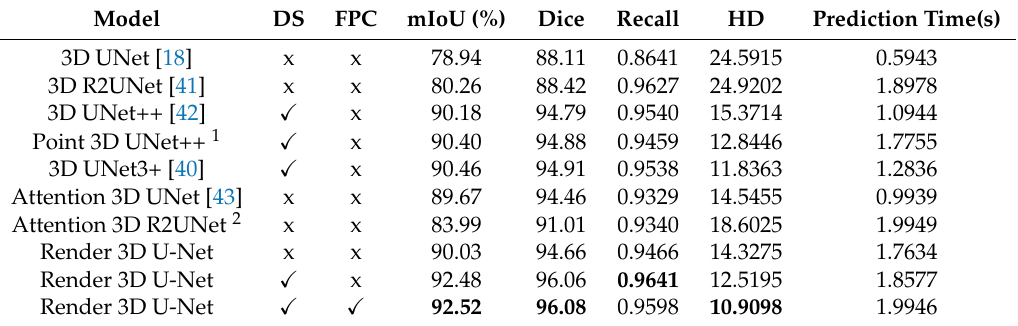
Table 2. The liver segmentation experiment results of the LiTS test